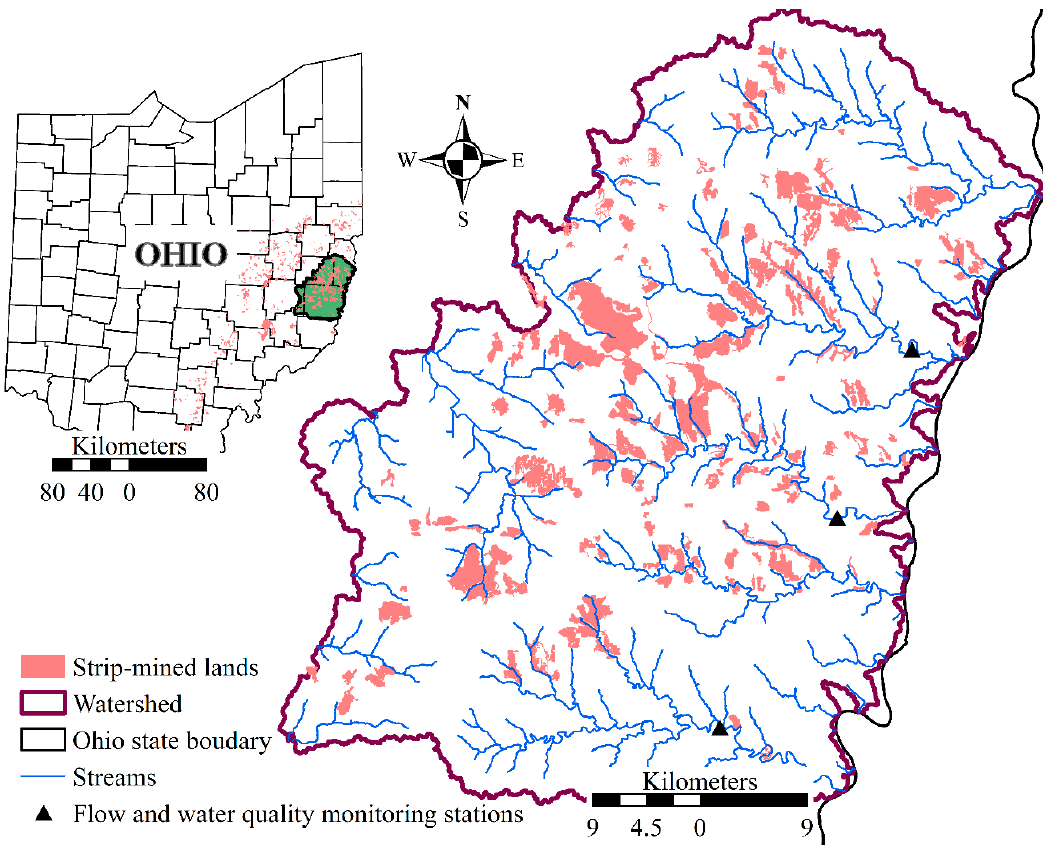
Figure 2. Delineation of studied watershed and streams in the state of Ohio with strip-mined land (SML).